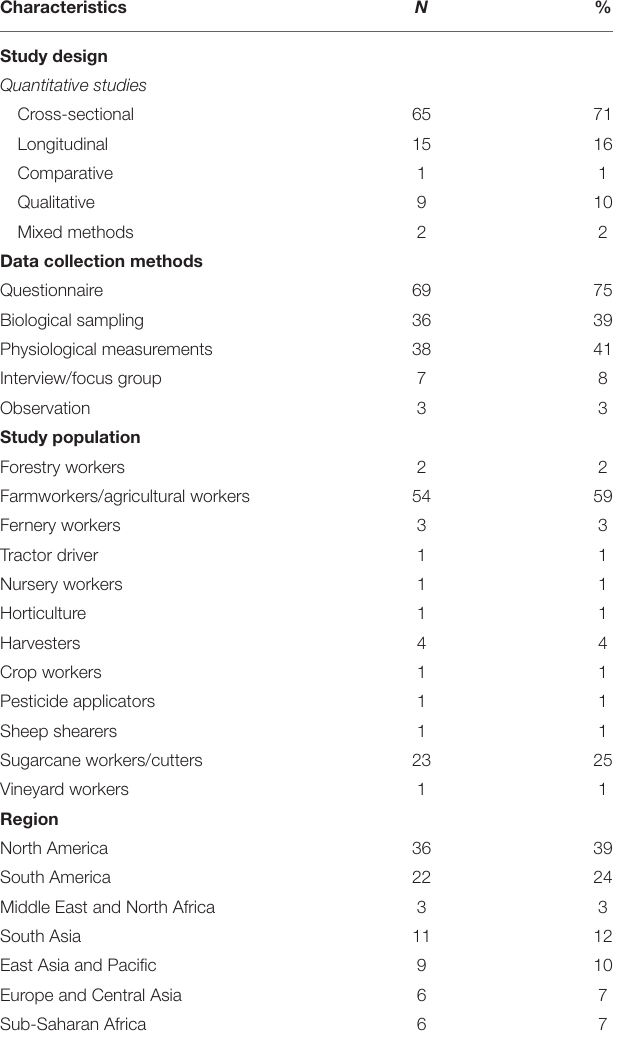
TABLE 1 | Descriptive characteristics of the included